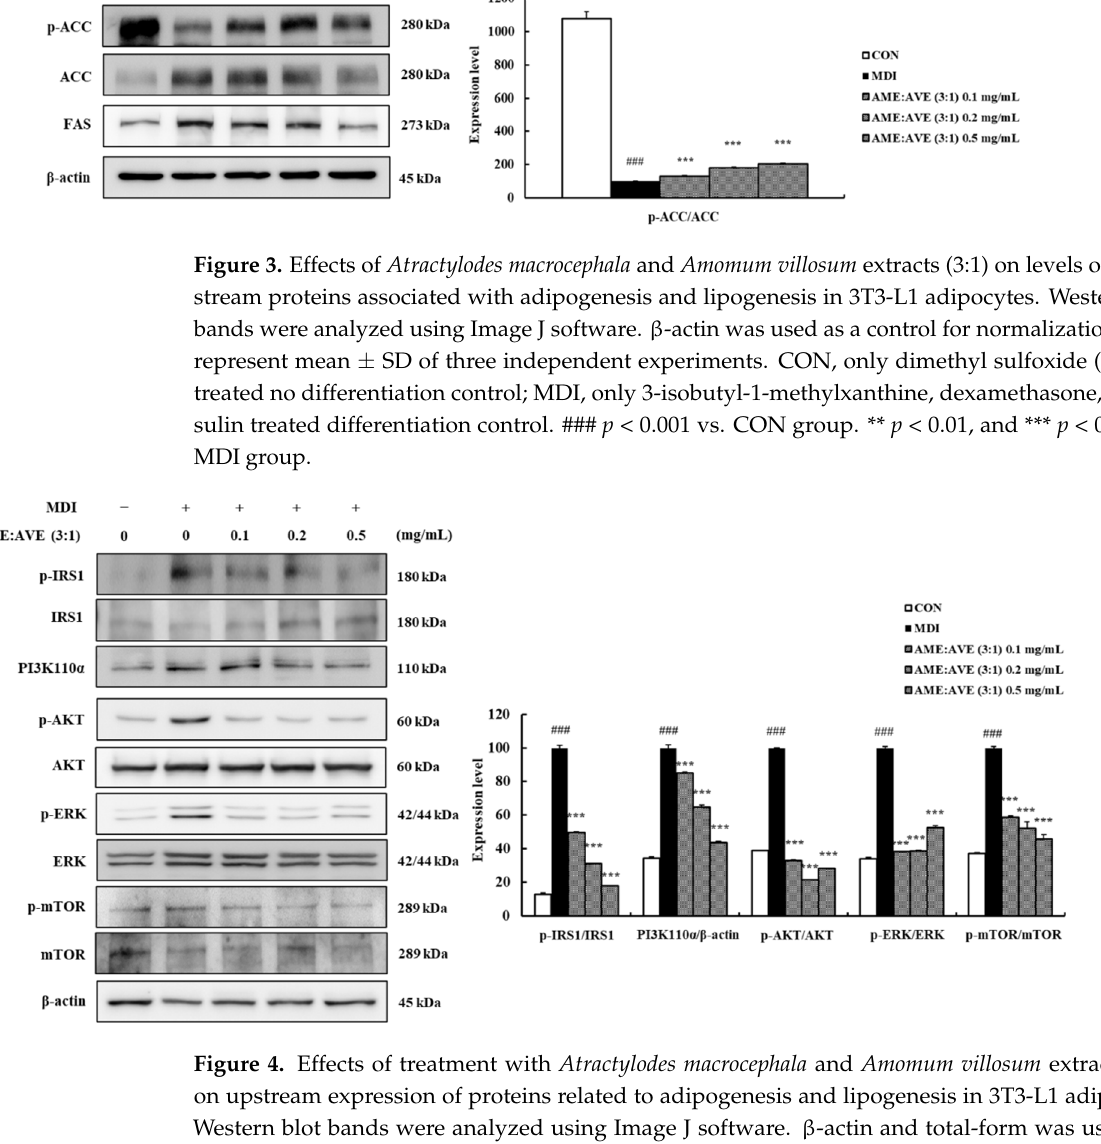
Figure 3. Effects of Atractylodes macrocephala and Amomum villosum extracts (3:1) on levels of down- stream proteins associated with adipogenesis and lipogenesis in 3T3-L1 adipocytes. Western blot bands were analyzed using Image J software. β -actin was used as a control for normalization. Data represent mean ± SD of three independent experiments. CON, only dimethyl sulfoxide (DMSO) treated no differentiation control; MDI, only 3-isobutyl-1-methylxanthine, dexamethasone, and in- sulin treated differentiation control. ### p < 0.001 vs. CON group. ** p < 0.01, and *** p < 0.001 vs. MDI group.